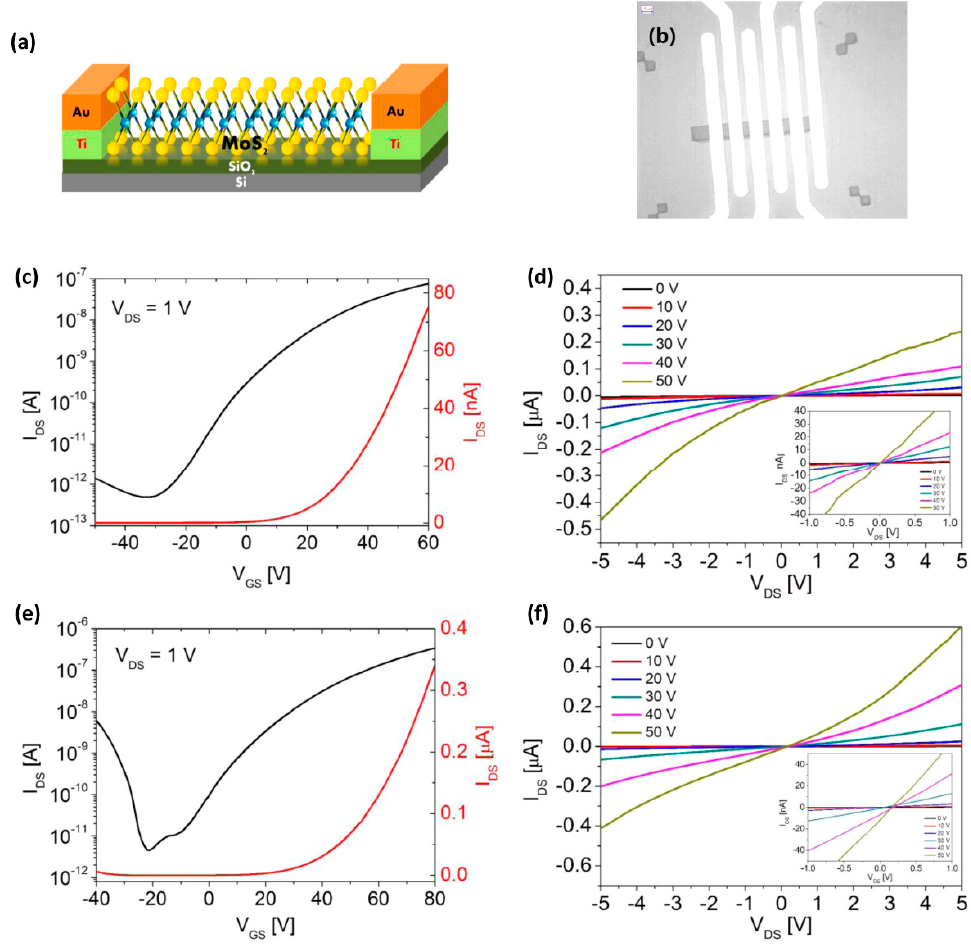
Figure 5. Electronic properties of the fabricated MoS 2 FETs. ( a ) 3D schematic and ( b ) optical images of the MoS 2 FET. ( c , e ) Transfer characteristics (I DS , vs. V DS ) at various V GS of 0–50 V for ( d ) trilayer and ( f ) few-layer MoS 2 films. Reproduced with permission from [39] . Elsevier Ltd 2017.